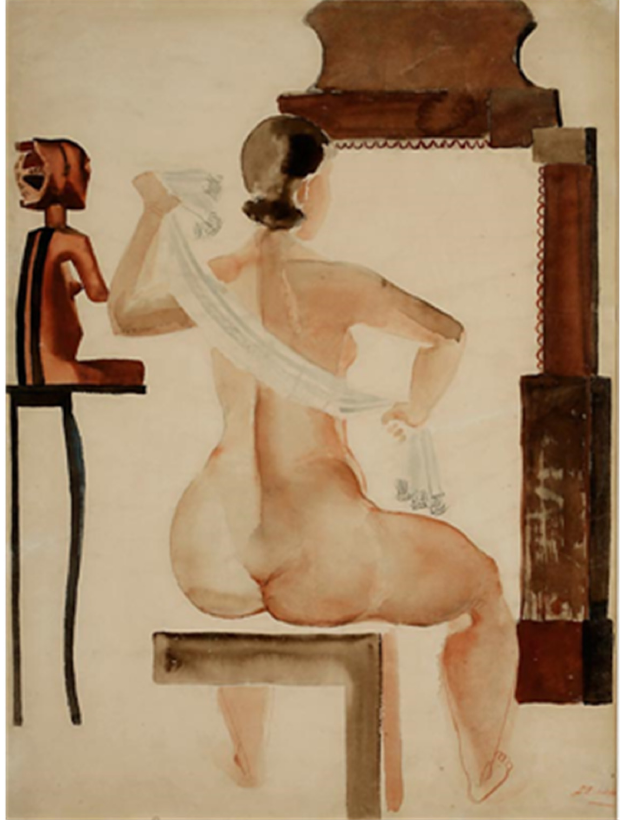
Figure 6. Aleksandr Deineka. “The Model in Front of a Mirror” (watercolor, 1928).